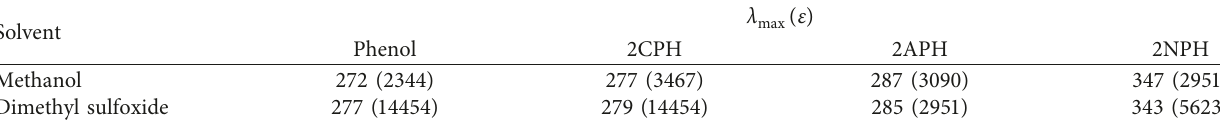
max . max ) and molar absorptivity ( ε ) of the phenols. ε λ max ( )